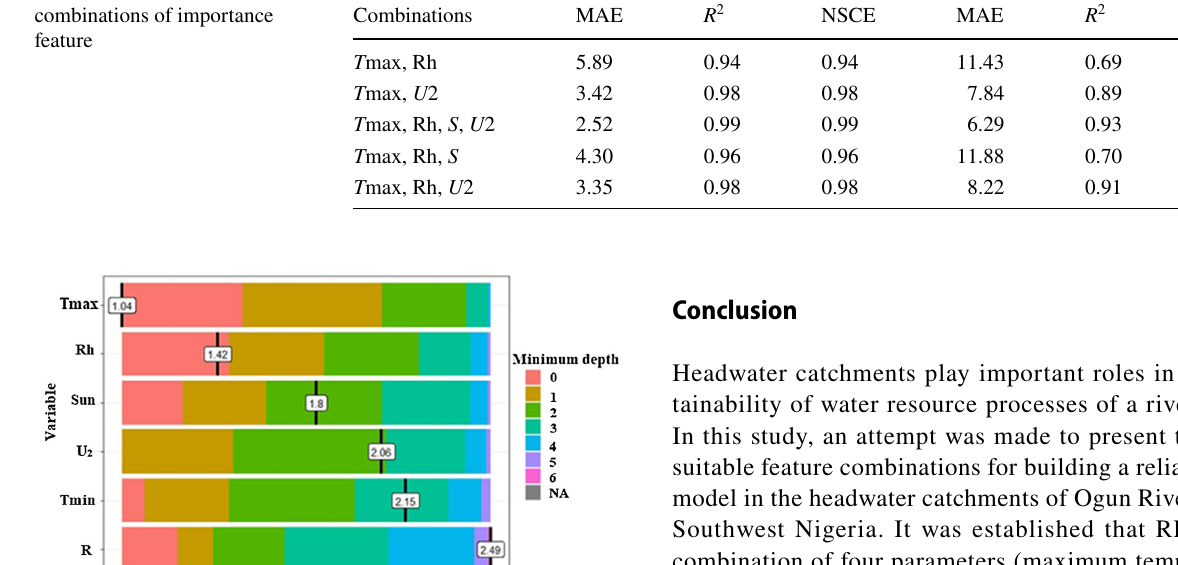
Table 3 Performance of RF models based on different combinations of importance feature